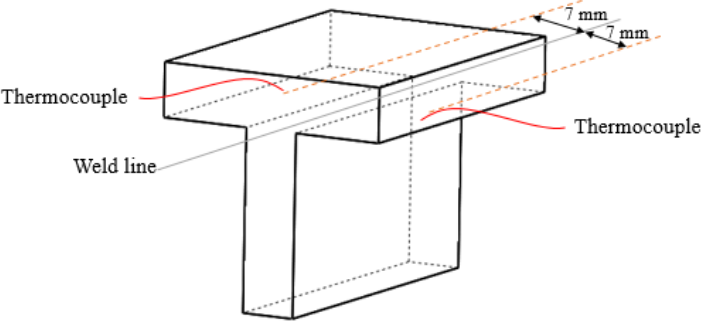
Figure 5. Schematic representation of the location of the thermocouple.